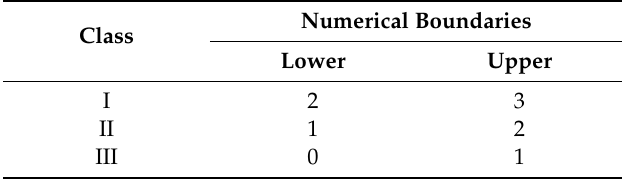
Table 5. Classification and assigned numerical